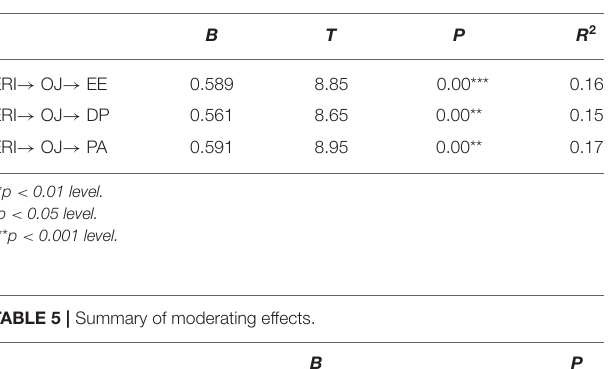
FIGURE 1 | Moderating effects of STT on EE through ERI.